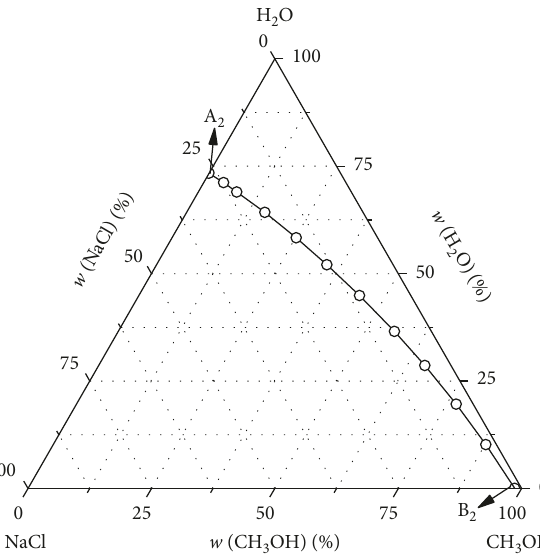
Figure 2: Phase diagram of the ternary system (NaCl + CH H 2 O) at 298.15 K.